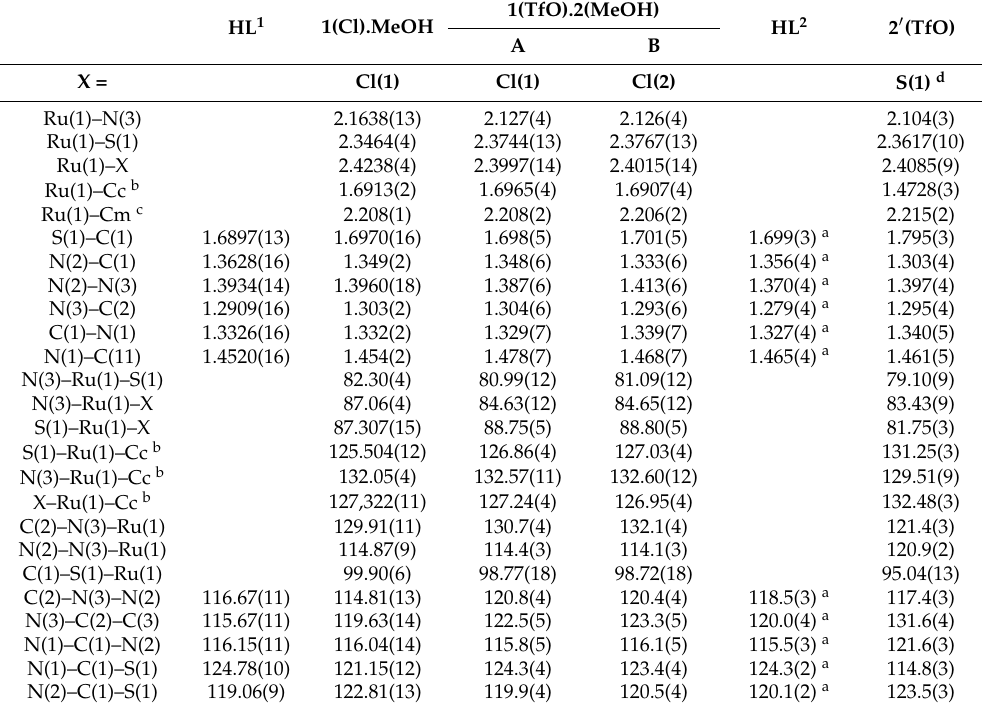
Table 2. Selected bond lengths (Å) and angles ( ◦